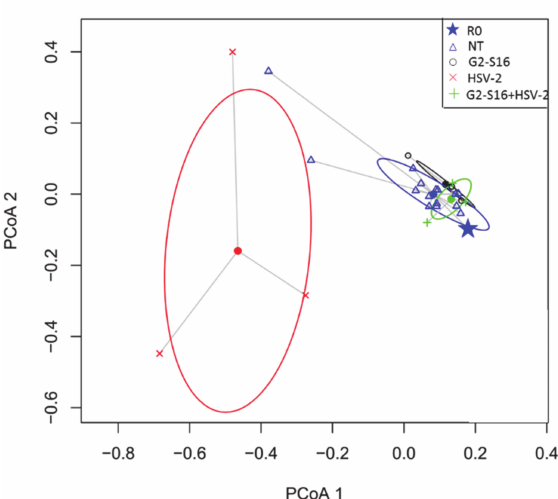
Figure 4. Principal Coordinate Analysis (PCoA). Analysis of multivariate homogeneity of group dispersions (variances) comparing Bray–Curtis distances. The figure shows the major PCo1 and PCo2. Ellipses show the standard deviation. Filled dots represent the median of the values in each group. Group NT or healthy mice, Sample “R0” (see Supplementary Figure S1) is marked with a star. Group G2-S16 or mice treated with G2-S16 dendrimer. Group HSV-2 or mice infected with HSV-2 and, group G2-S16 + HSV-2 or mice treated with G2-S16 dendrimer and infected with HSV-2. Further explanation can be found in the